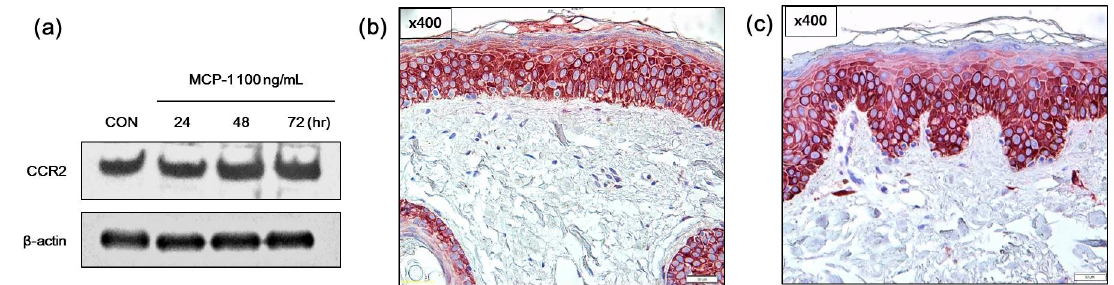
Figure 2. Effects of monocyte chemoattractant protein-1 (MCP-1) on CCR2 expression in ( a ) normal human melanocytes (NHMs) were evaluated by Western blotting. Cells were treated with 100 ng/mL MCP-1 for the indicated times. Cell lysates were assessed by Western blot analysis using antibodies against CCR2. β -actin was used as the loading control. Immunohistochemical analysis of CCR2 expression in ( b ) normal skin tissue and ( c ) SL tissue (scale bar: 50 µm). In both normal skin tissue and SL tissue, CCR2 staining was observed in the epidermal constituent cells including keratinocytes and melanocytes.